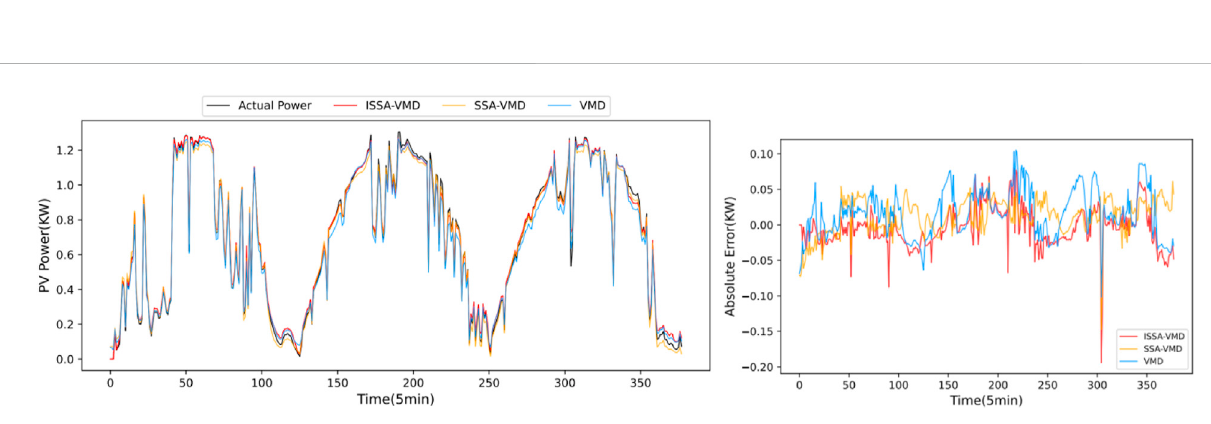
FIGURE 13 Prediction outcomes and error distribution using different decomposition methods on cloudy days.